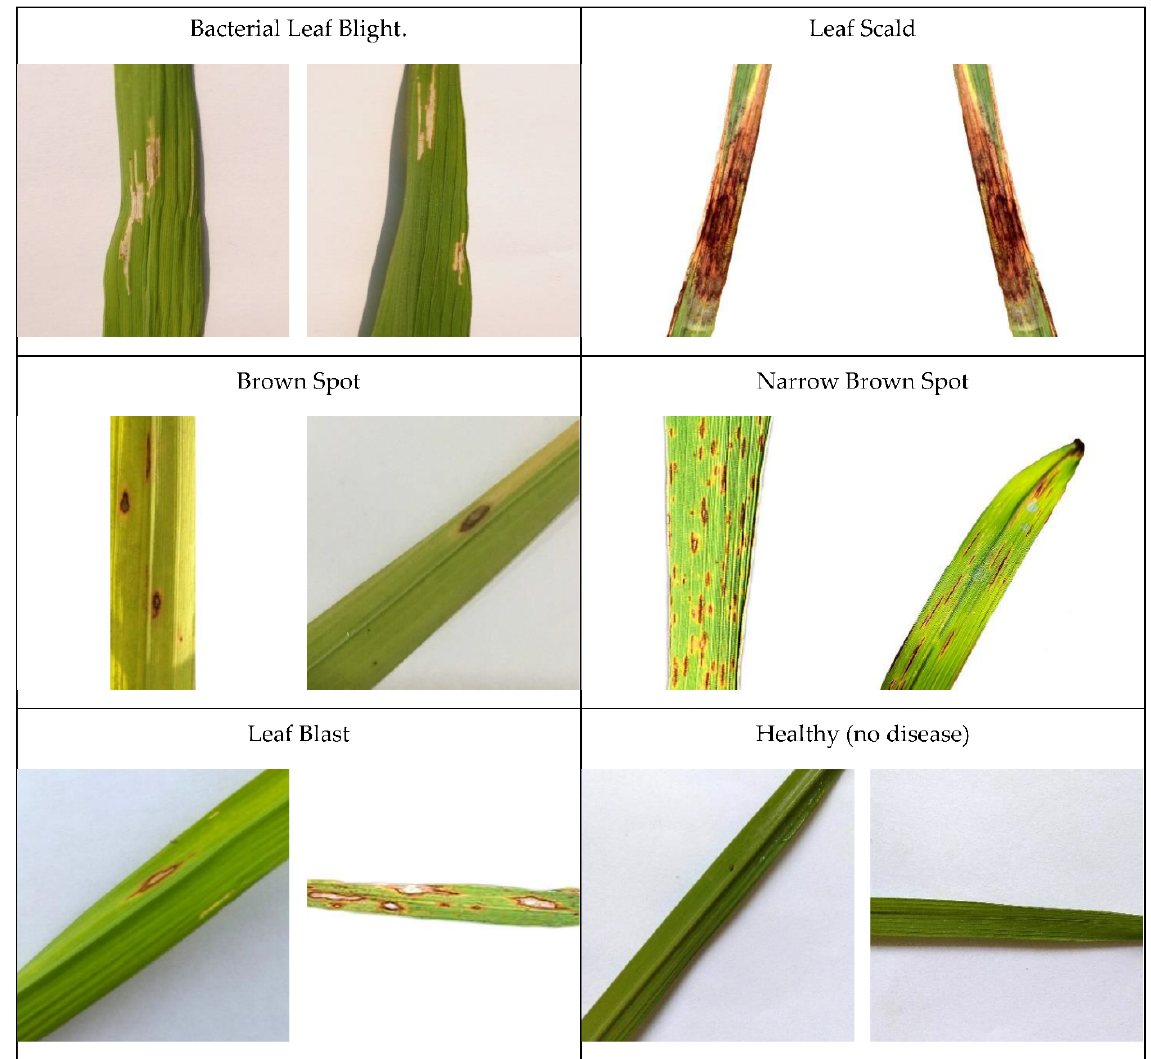
Figure 3. Sample Images of rice leaf diseases.